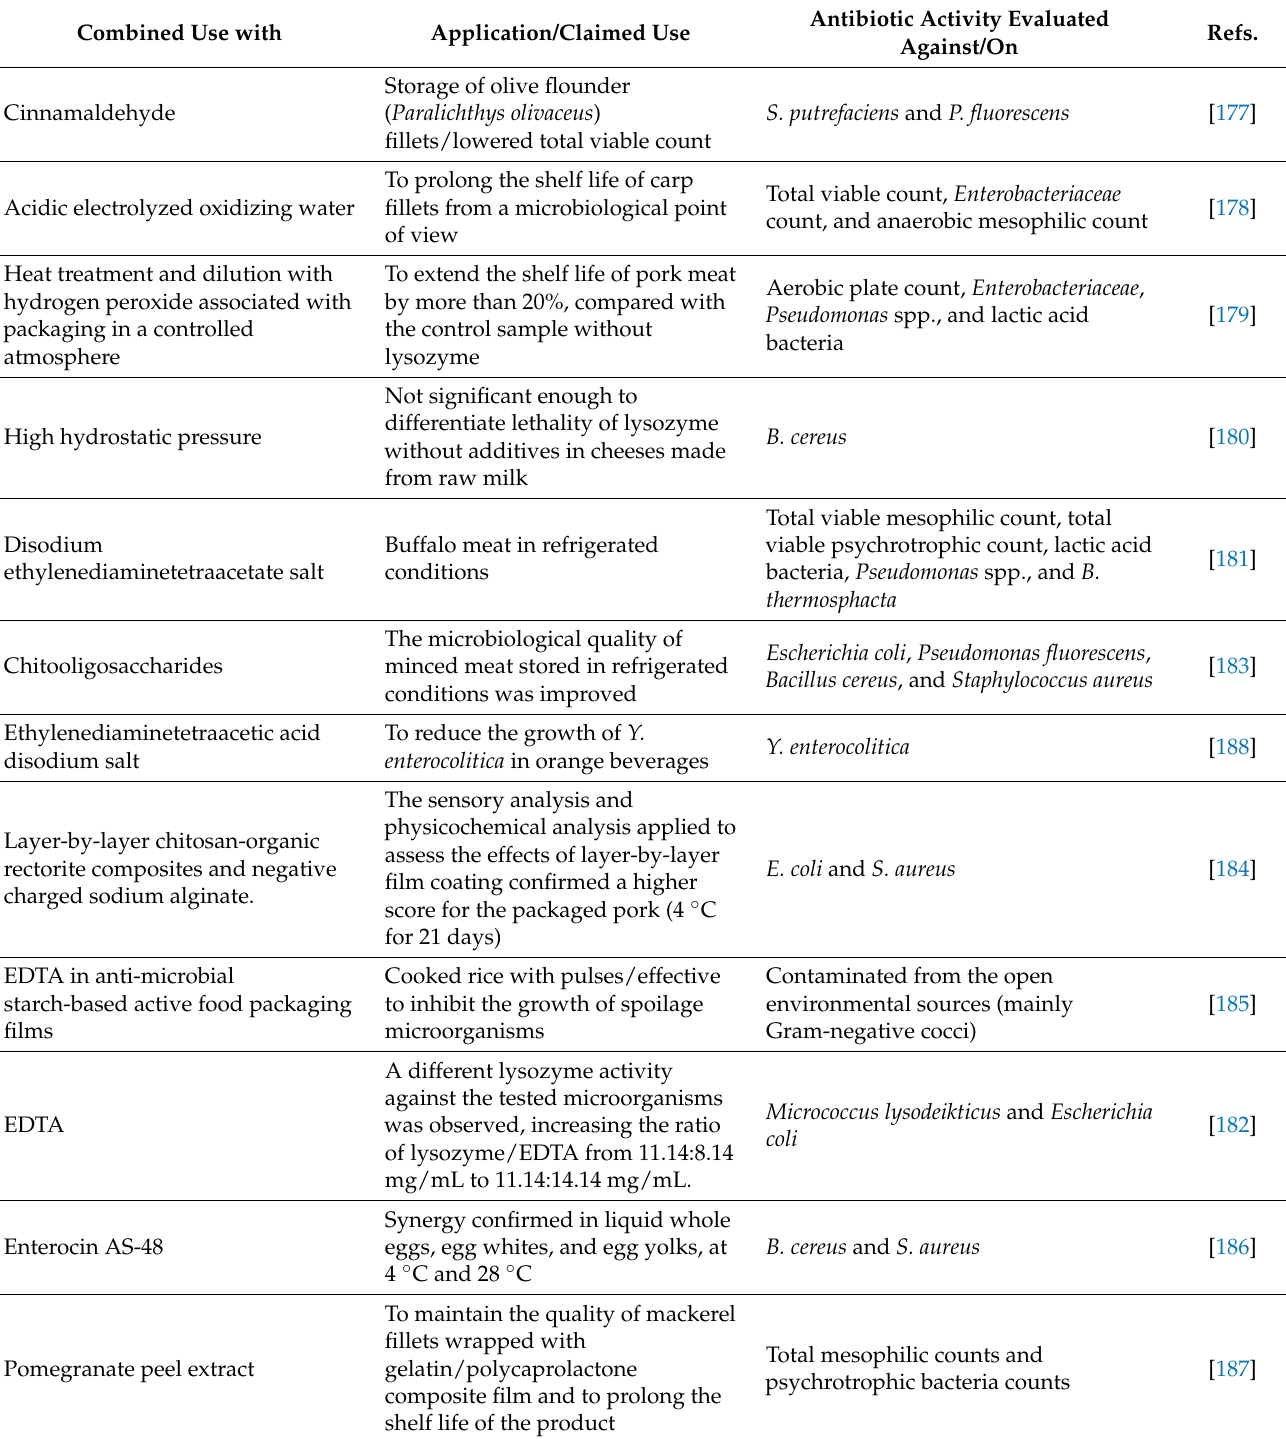
Table 1. Relevant data on the synergic uses of different substances with lysozyme, in order to enhance the susceptibility of Gram-negative